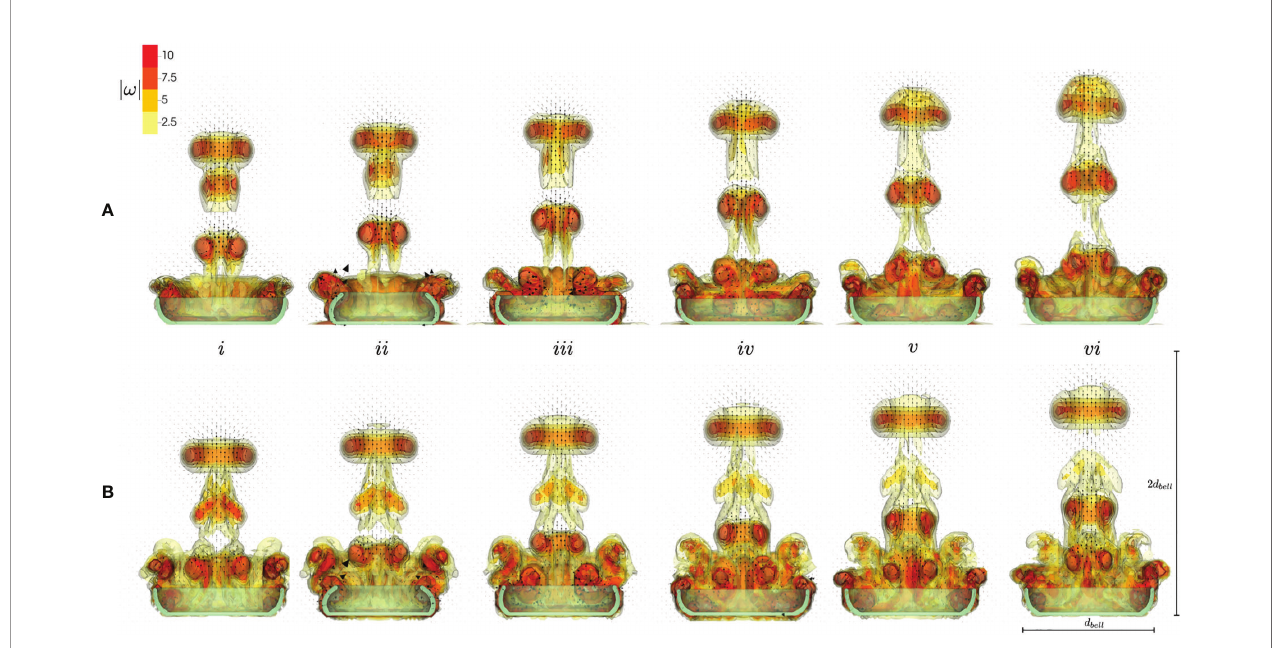
FIGURE 6 | Velocity vectors overlaid on contours of vorticity magnitude, obtained from numerical simulations. Vorticity and velocity vectors were extracted at a 2D slice through the center of the numerical bell. Numerical simulations include a medusa resting against the substrate ( A , top) and with no substrate ( B , bottom). Snapshots show the beginning of the fourth stroke cycle (i) and 20%, 40%, 60%, 80%, and 100% through the stroke cycle (ii-vi). where each velocity peak corresponds to the location of a vortex ring. As the vortices are advected upwards, the peak velocities are translated to the right as time increases.